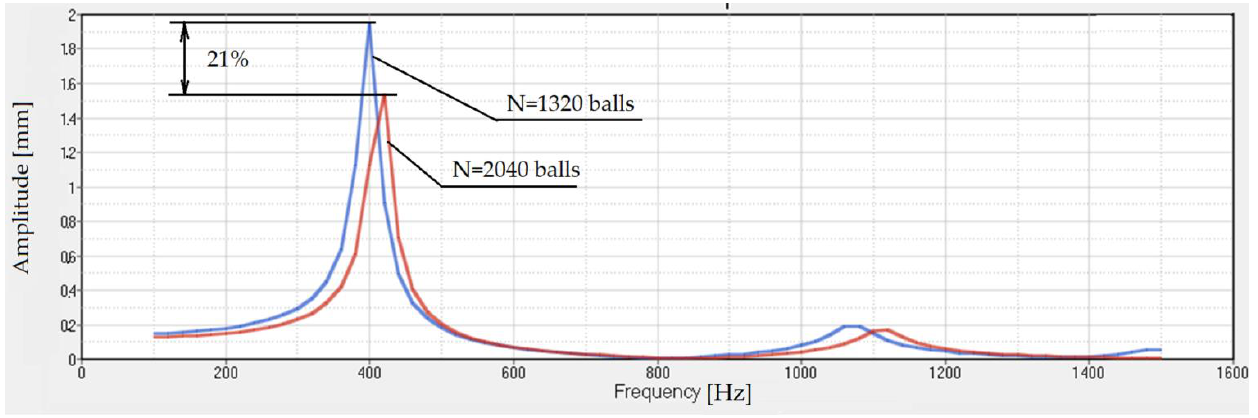
Figure 14. Comparasion Transmissibility for structural damping